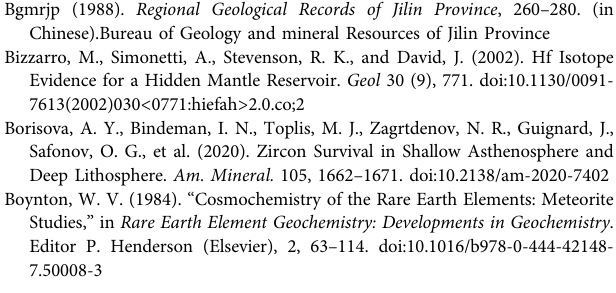
Frontiers in Earth Science |